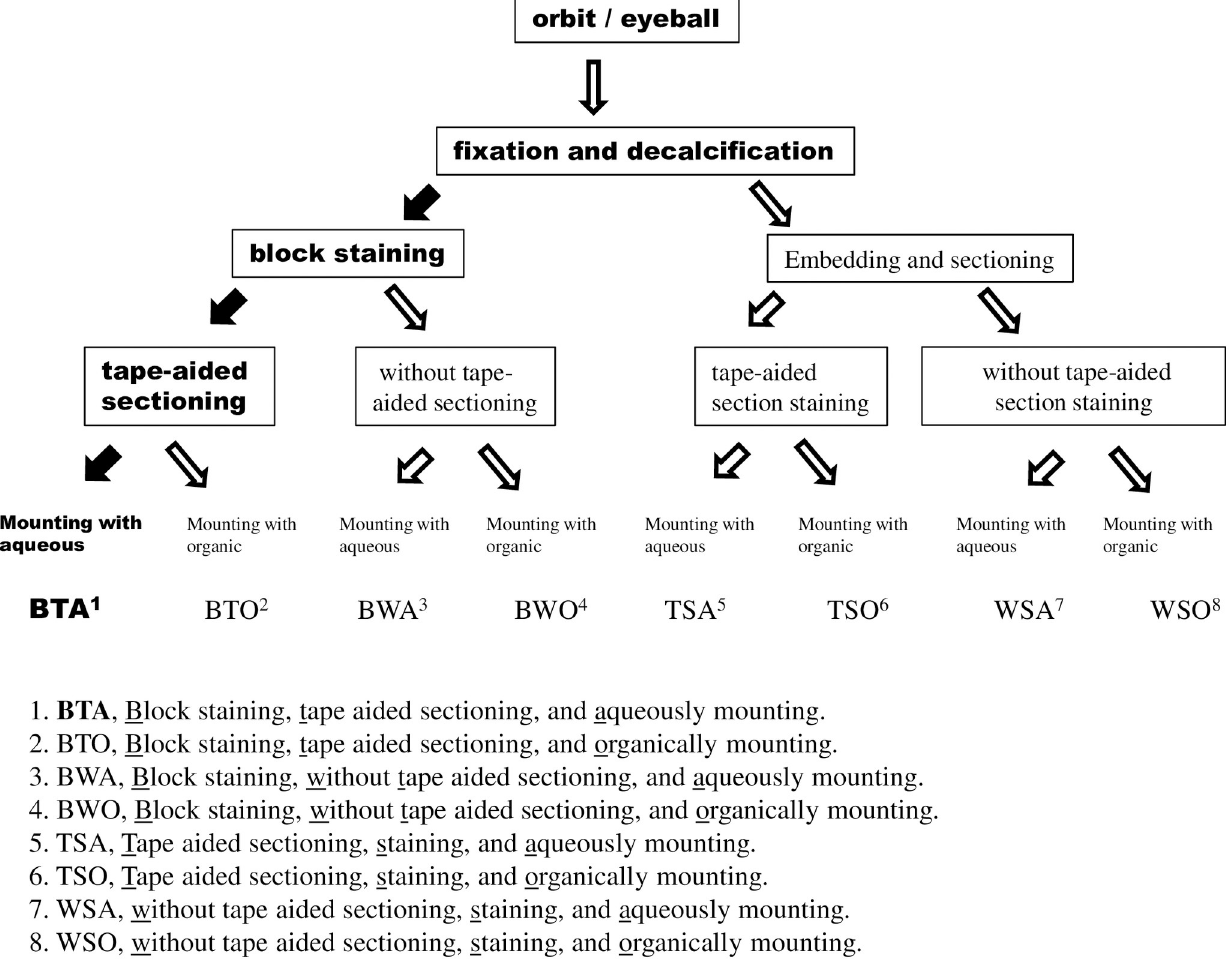
Fig 2. Flow chart of different